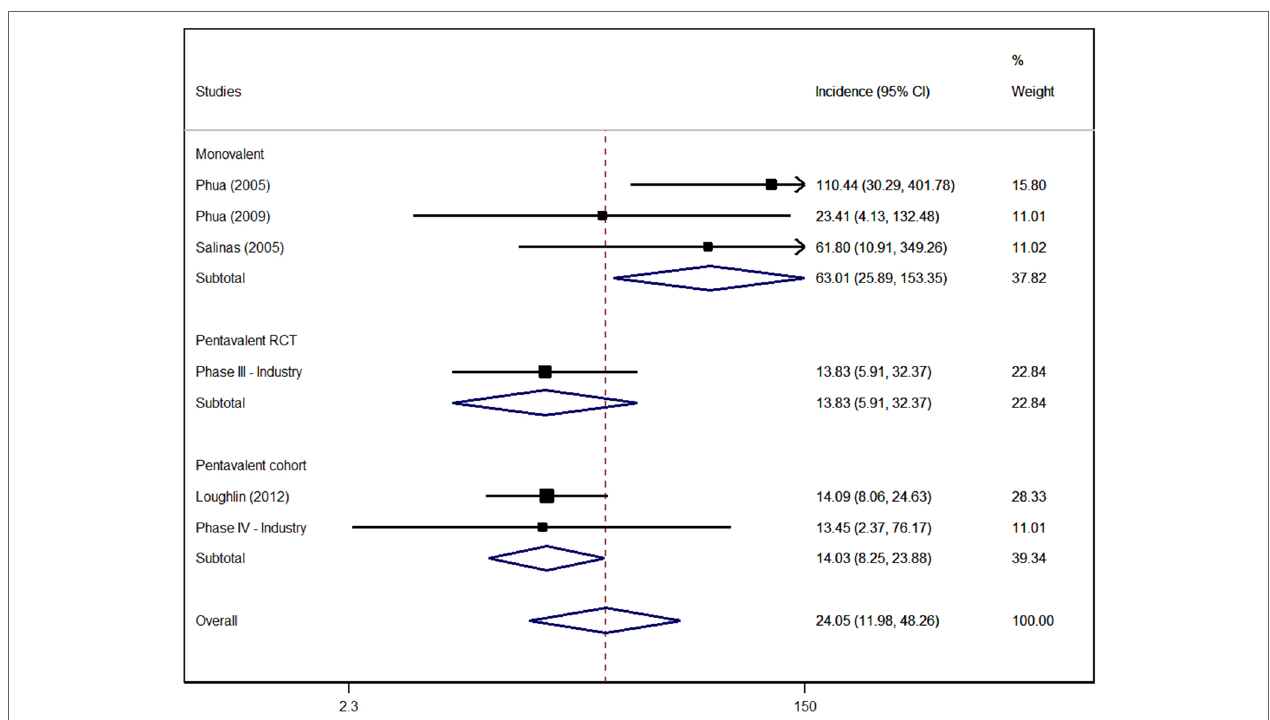
FIGURE 2 | Incidence of Kawasaki disease (per 100,000 children) due to use of rotavirus